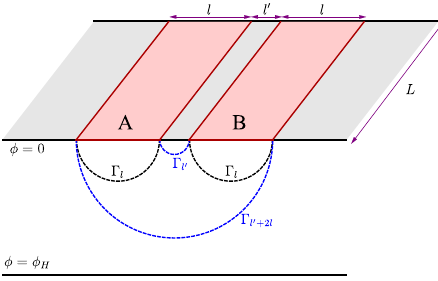
Fig. 6 Left: A simplified sketch of a strip region A with width l and length L . (cid:12) A is the RT-surface of the region A and φ ∗ is the turning point of this surface. Right: A simplified sketch of two strip regions A and B with equal size l which are separated by the distance l (cid:3) . When l (cid:3)